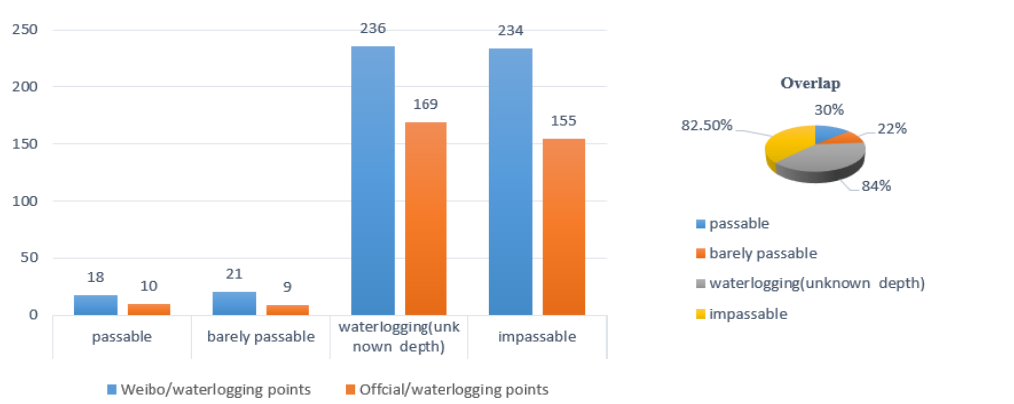
Figure 3. Comparison of the number and overlap of Weibo and official waterlogging points. Figure 3: We can find that the waterlogging points of urban